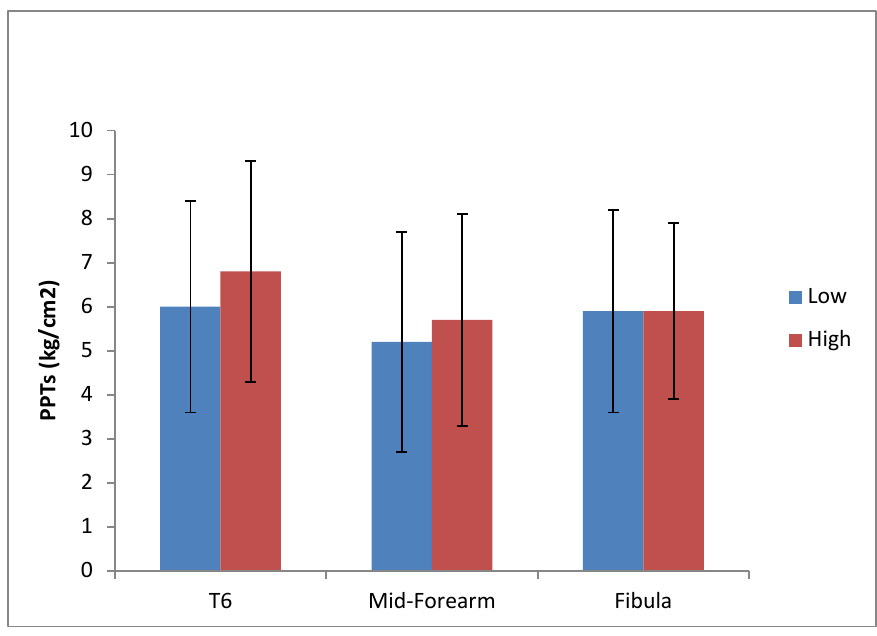
Figure 7. Changes in PPT at each site after high and low force interventions .